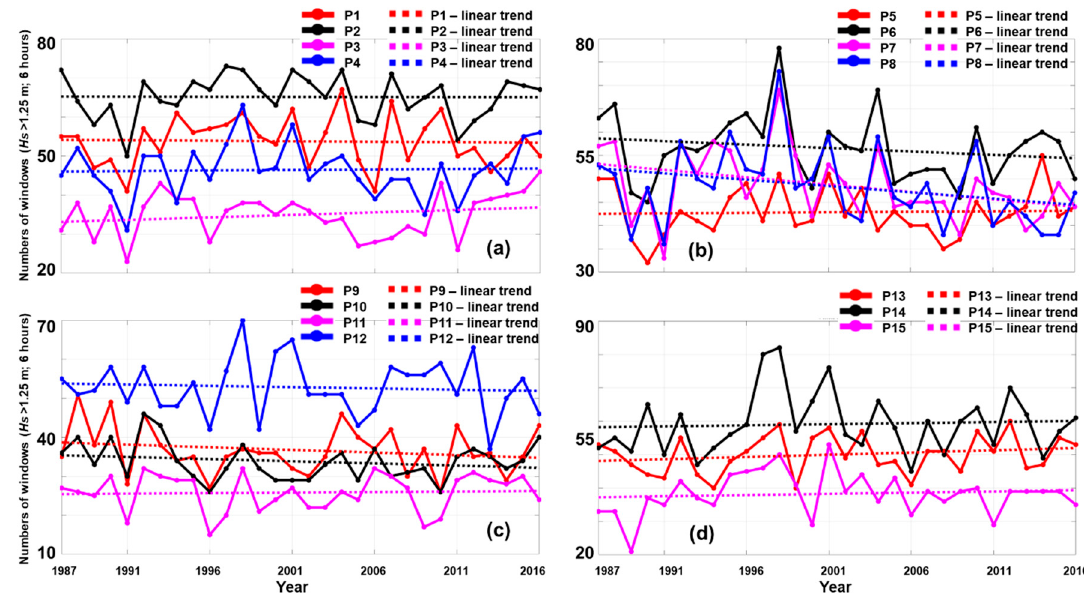
Figure 13. The number of windows of 6 h above 1.25 m threshold, where: ( a ) P1–P4 sites; ( b ) P5–P8